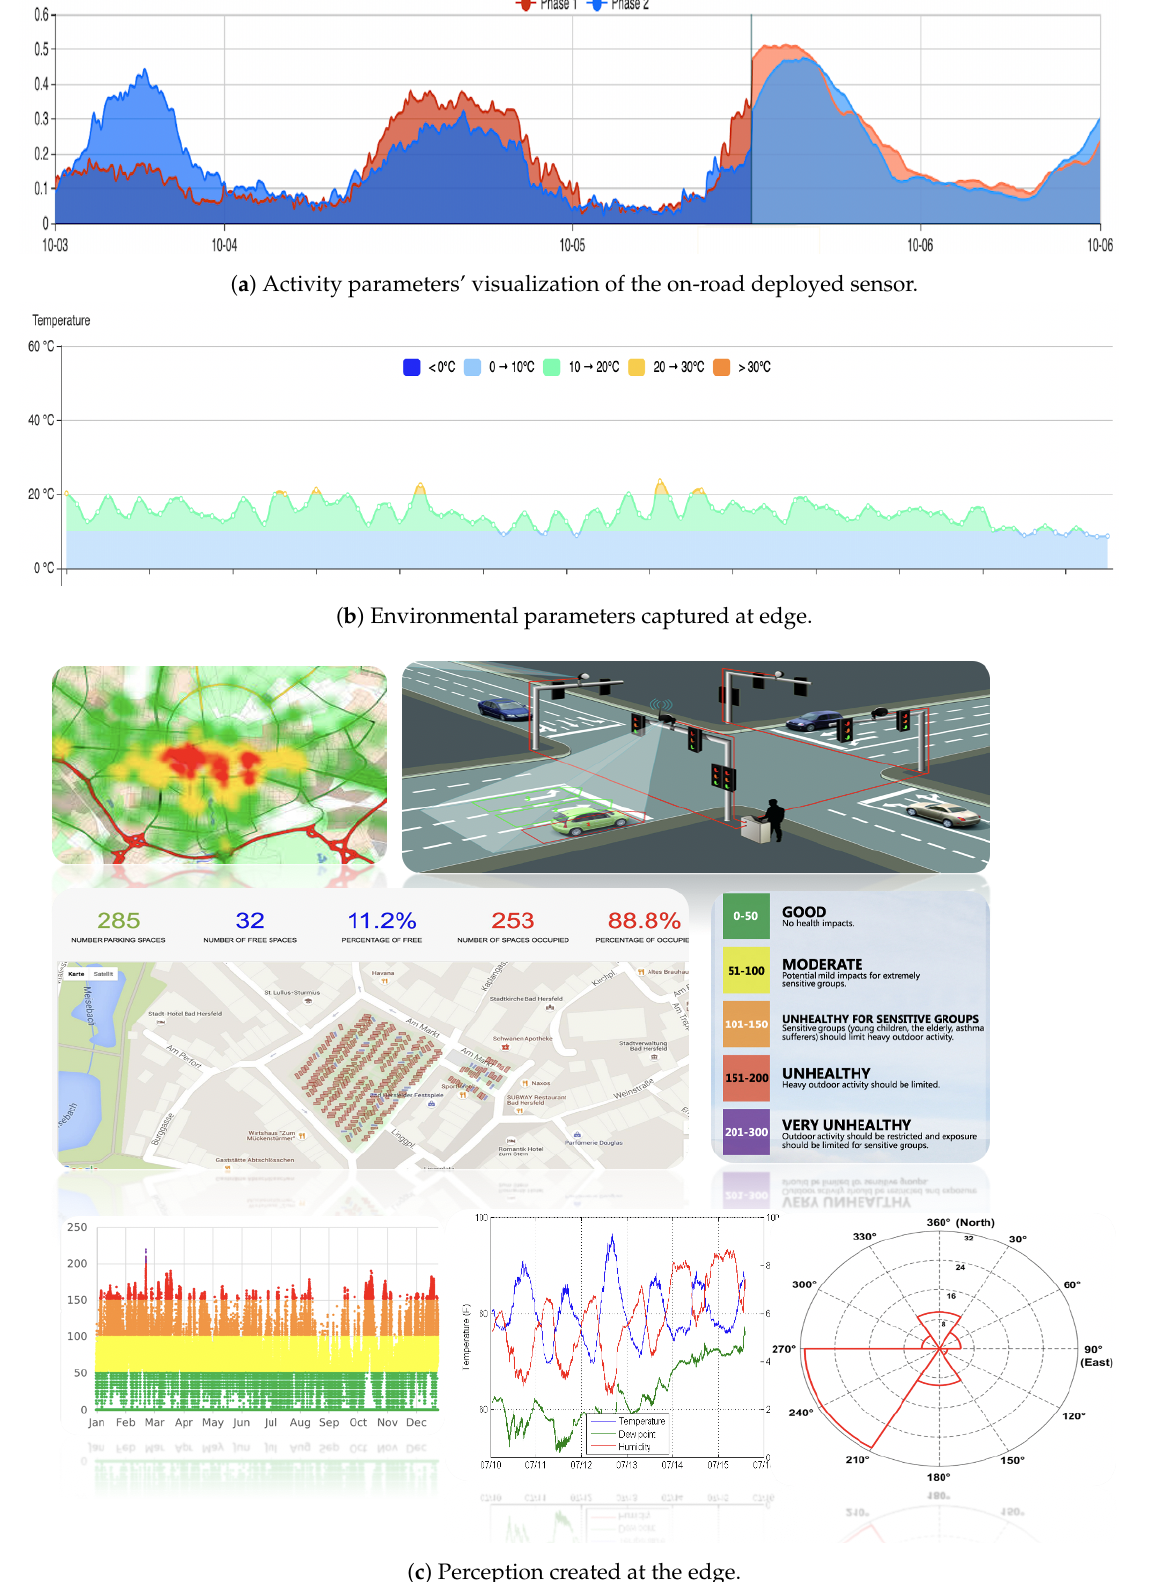
Figure 4. A look into some of the visualizations of activity and environmental